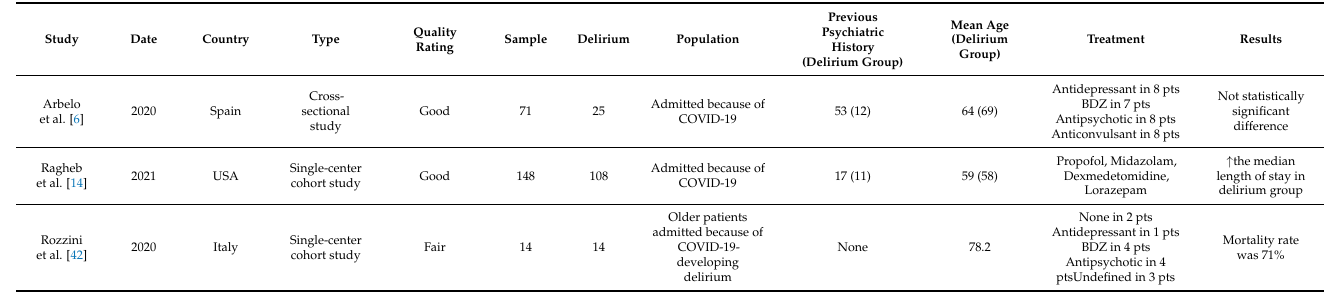
Table 2. Characteristics of the other types of studies included in the systematic review.